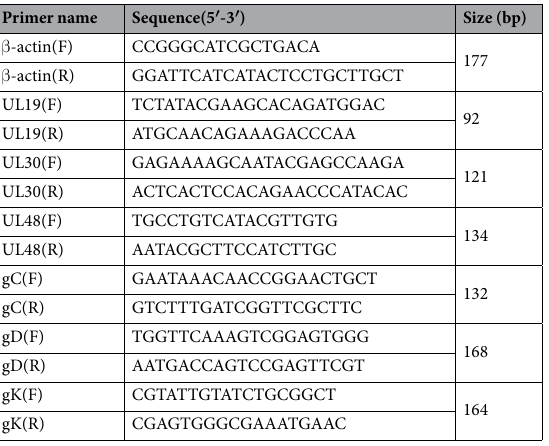
Table 1. Primers for real-time